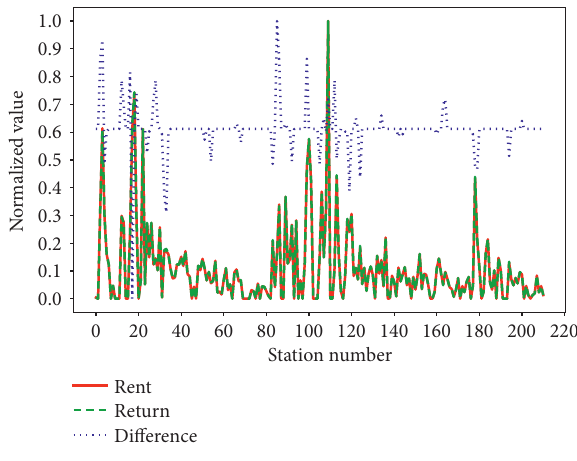
Figure 6: Distribution of imbalance.